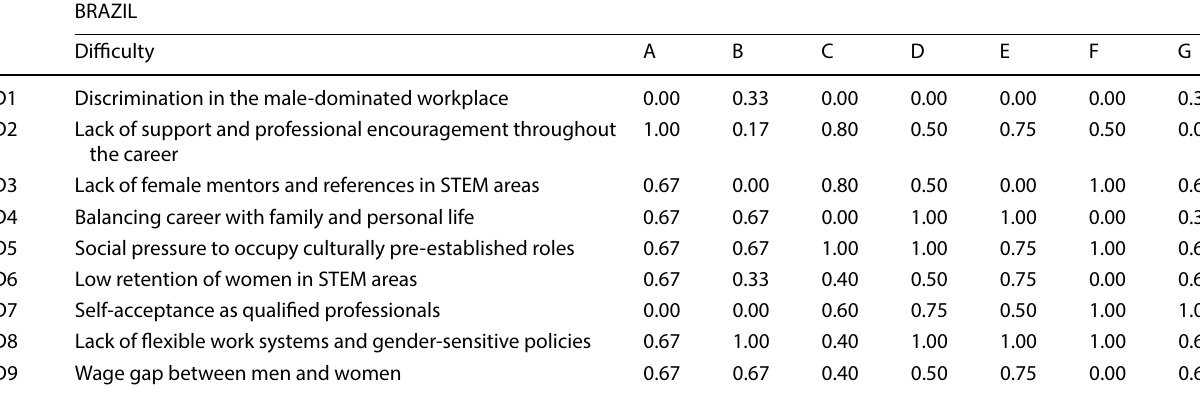
Table 3 Normalization of the scores assigned by the participants for each difficulty in Brazil